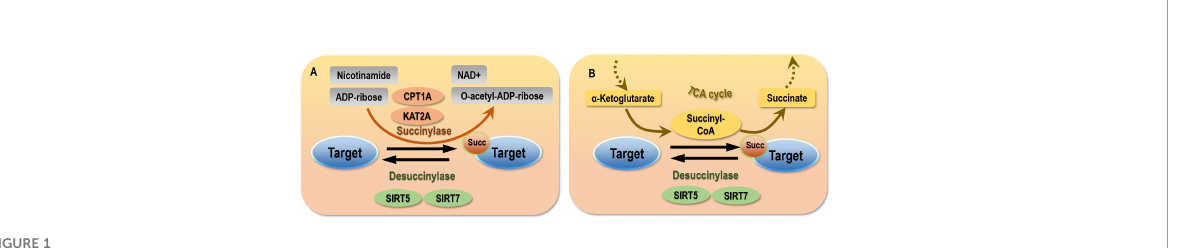
FIGURE 1 Mechanism of succinylation. (A) Enzymic succinylation. (B) Non-enzymic succinylation. Succinylases such as CPT1A and KAT2A are required in enzymic succinylation. Suf fi cient succinyl-CoA supply is a pre-requisit for the occurrence of non-enzymic succinylation. Desuccinylases such as SIRT5 and SIRT7 are required to erase succinylation marked via both enzymic and non-enzymic